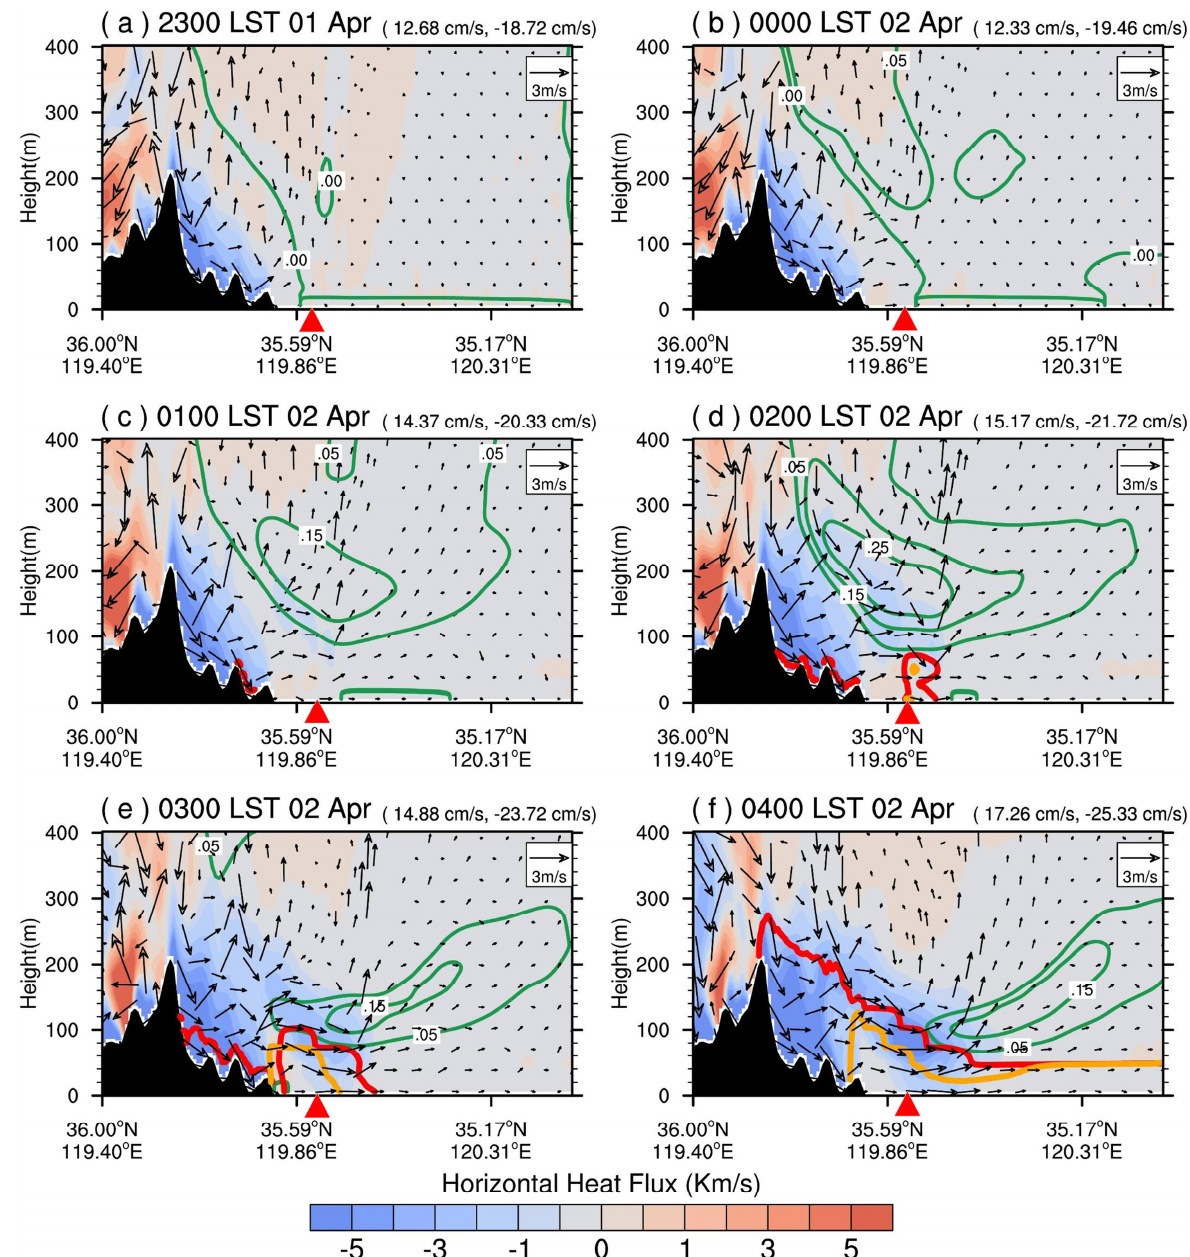
Figure 12. Evolution of horizontal heat flux (color shades) transported by offshore wind and sea fog during the formation stage of the land breeze circulation (vectors) in the vertical cross-section along the line A-B marked in Figure 1. Green contours are the mixing ratio increments of Exp-Ctrl relative to Exp-LB0. Sea fog vertical extents of Exp-Ctrl and Exp-LB0 are outlined by the coarse lines in red and orange colors, respectively. The red triangle indicates the location of vertical profiles in Figure 13. The information of time and maximal vertical velocities are shown at the top of the panels ( a – f ).